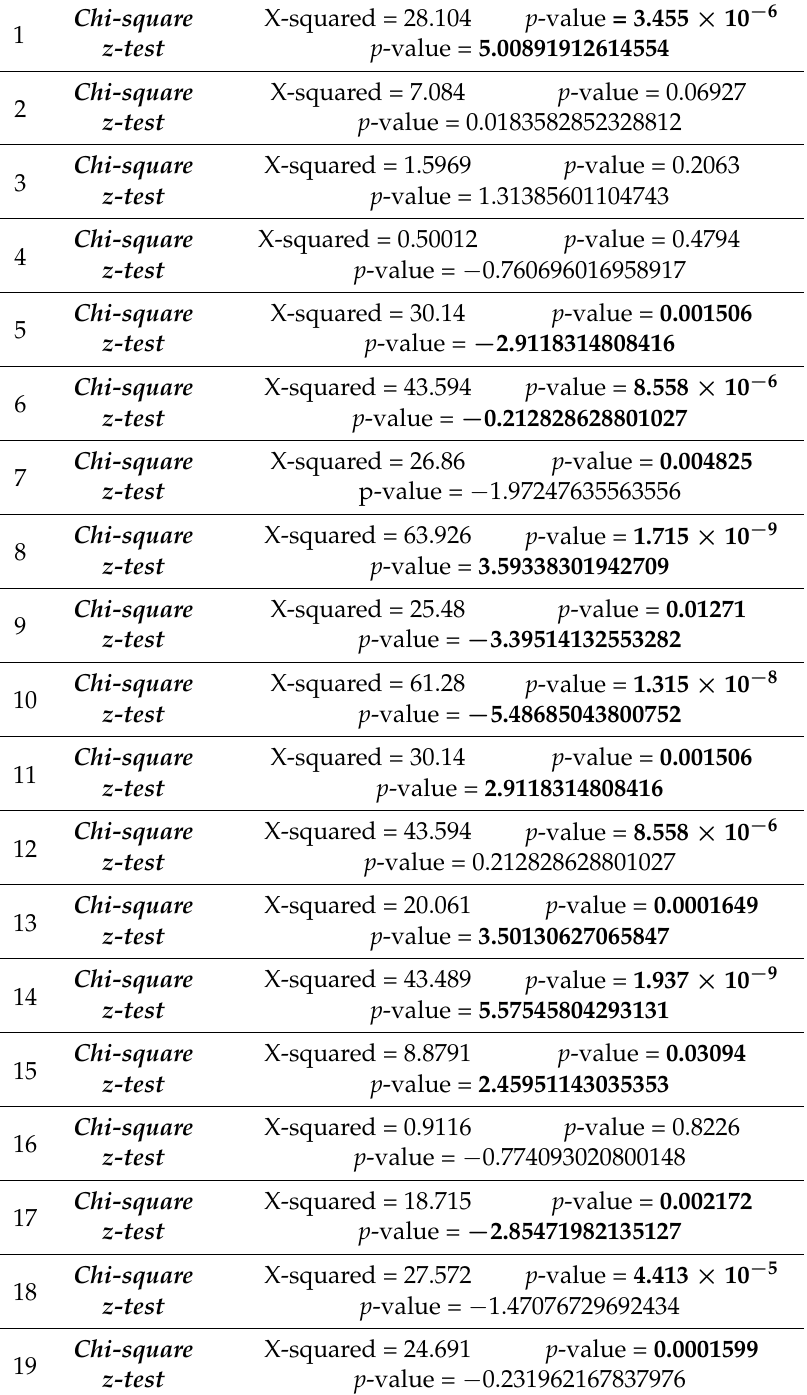
Table 15. Validation results of extracted associations from the HCAHPS data related to one hospital. (Linked to Table 10 by row number). Bold figures are p -values in accepted test